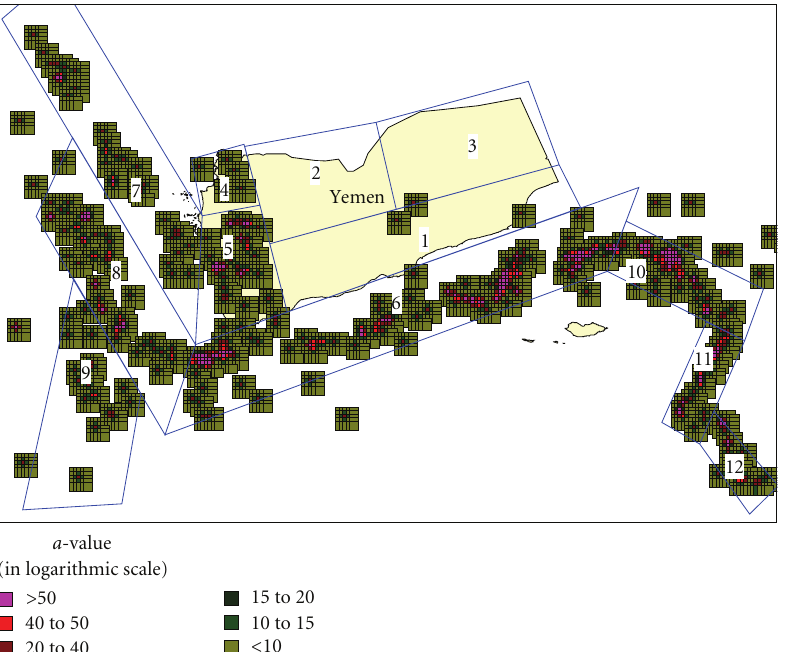
Figure 5: Delineated seismic sources (1–12) plotted upon the thematic map of the Frankel smoothed a -values. Source names are provided in Table 2.